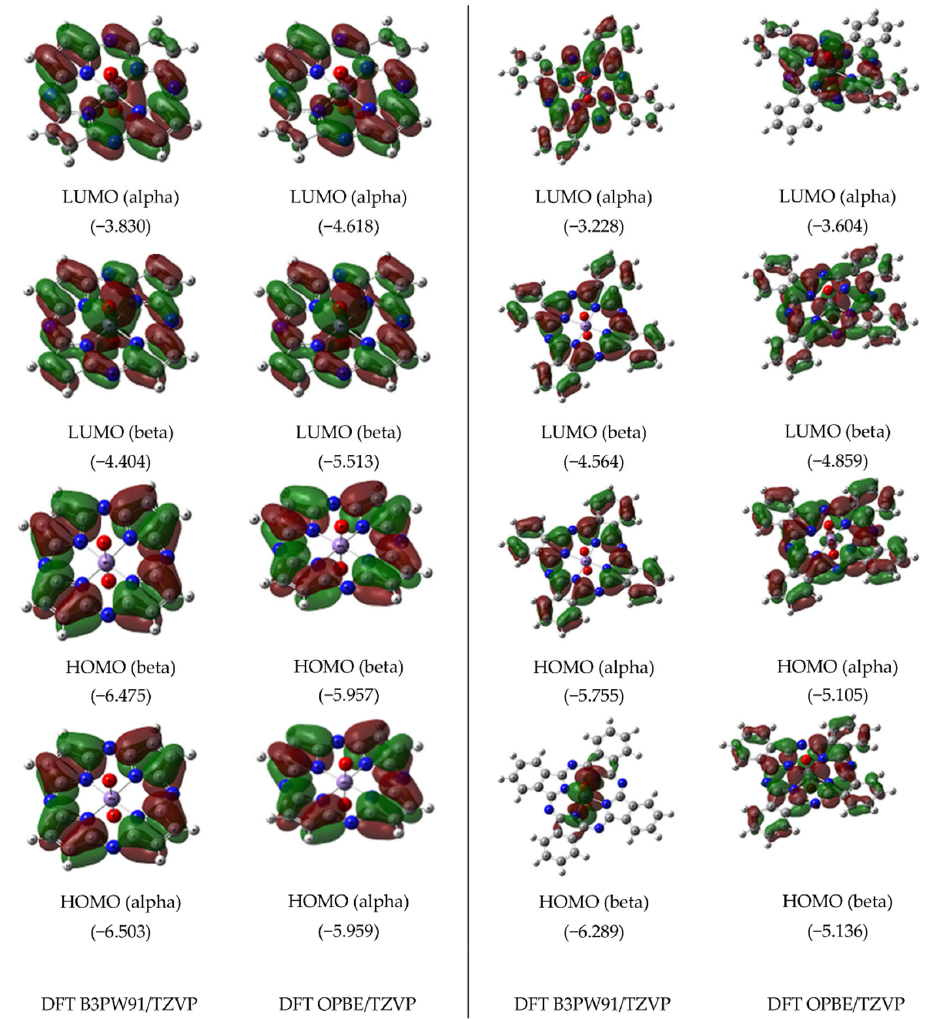
Figure 2. HOMO and LUMO images in the [Mn( P )(O) 2 ] ( left ) and [Mn( Pc )(O) 2 ] ( right ) complexes, according to the DFT B3PW91/TZVP and DFT OPBE/TZVP methods. The energies values of the given MOs (in brackets) are expressed in eV. The symbol “alpha” represents the electron with spin (+1/2), and the symbol “beta” represents the electron with spin ( − l/2).